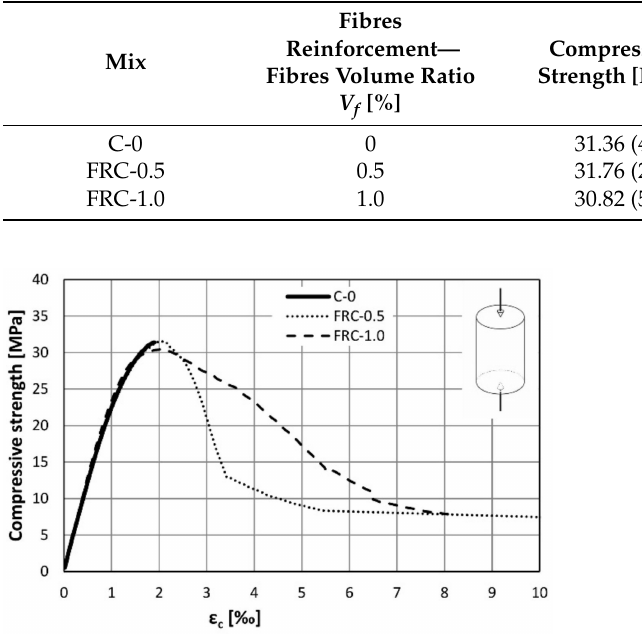
Figure 7. The stress-strain curves from the compression